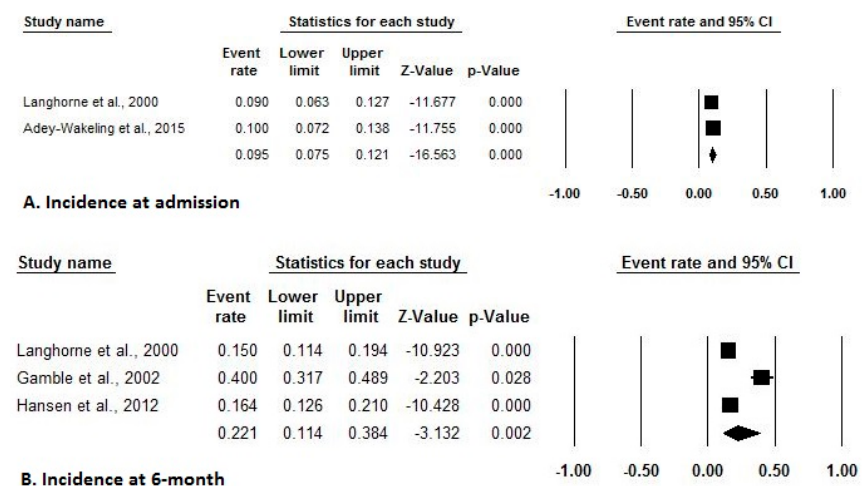
Figure 3. Incidence of shoulder pain after stroke (( A ). Incidence at admission, ( B ). Incidence at 6-month).